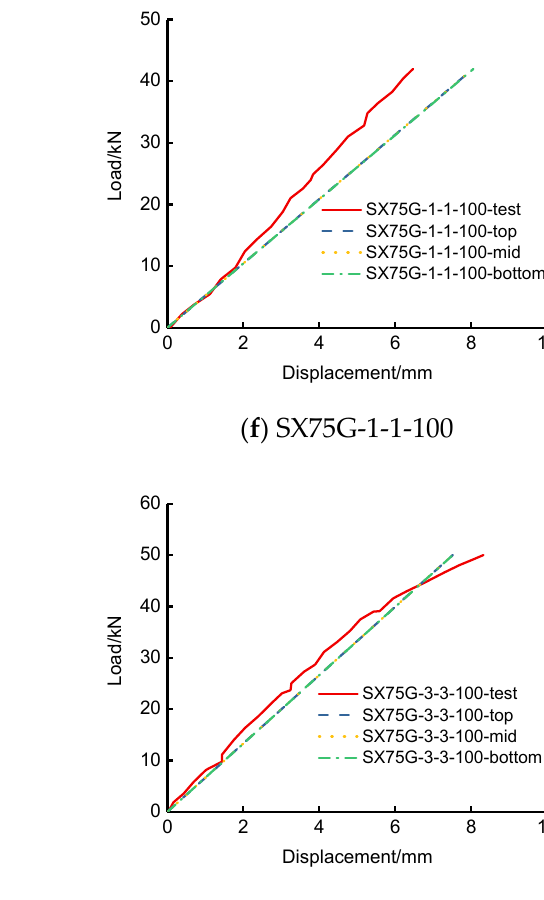
Figure 9. Load-midspan curves under the concentrated load for single-way simply supported SLCPs.